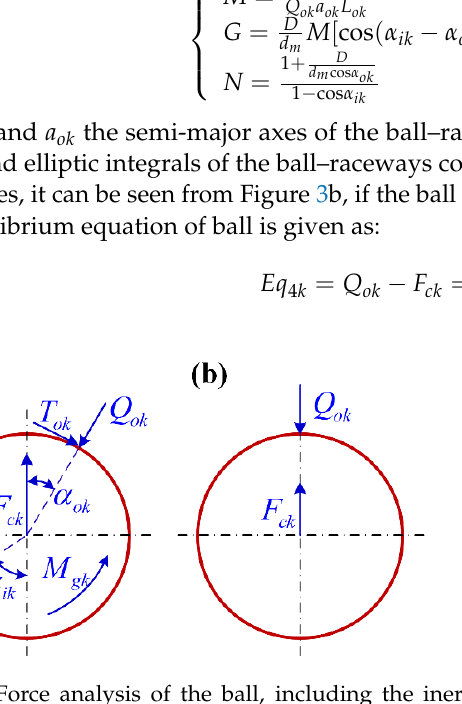
Figure 3. Force analysis of the ball, including the inertia forces ( F ck , M gk ) and contact forces ( Q i/ok , T i/ok ): ( a ) The ball contacts with inner ring; ( b ) The ball separates from inner ring.